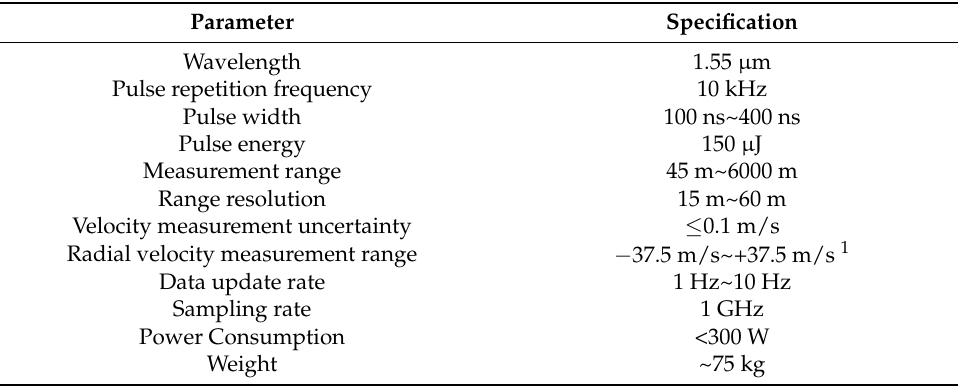
Table 2. Technical specifications of Wind3D 6000 scanning wind lidar.